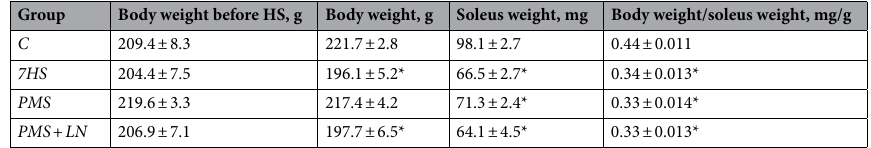
Table 2. Body weight and soleus muscle weight of experimental animals. Values are means ± SE. n, number of rats; C, vivarium control group; 7HS, hindlimb suspension for 7 days; PMS, hindlimb suspension for 7 days + plantar mechanical stimulation; LN, hindlimb suspension for 7 days + plantar mechanical stimulation + L-NAME injection. *Significant difference from